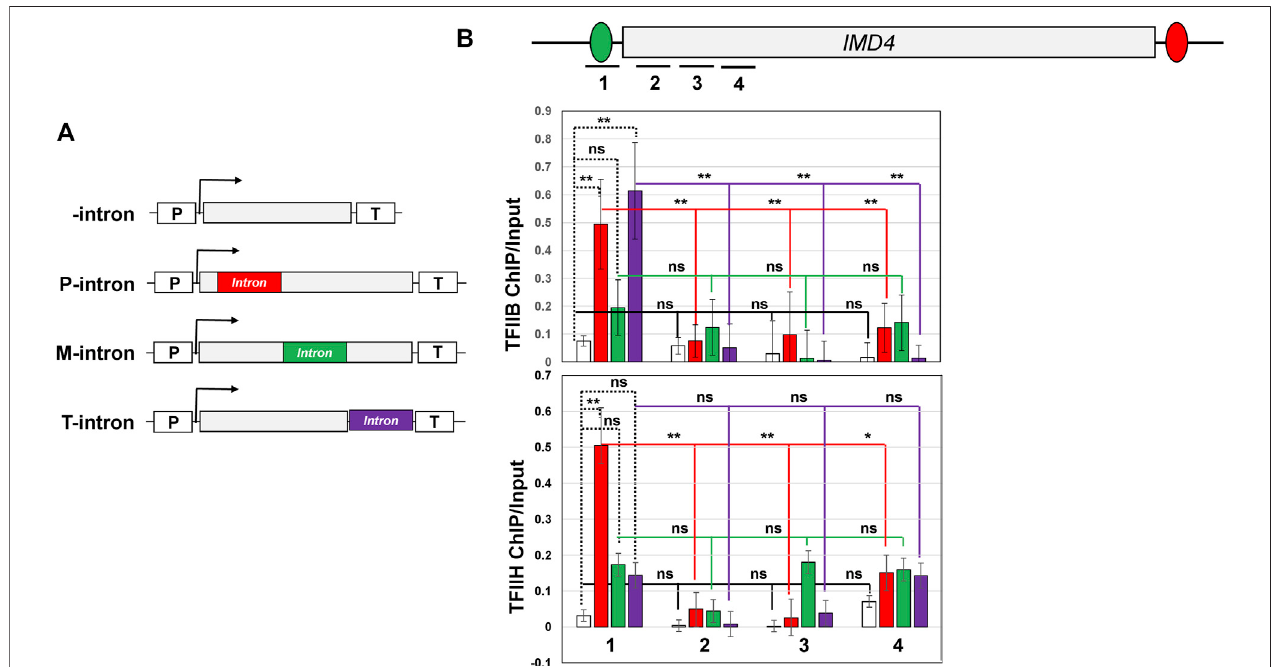
FIGURE5| PositionofintronaffectsTFIIBandTFIIHpromoteroccupancyfor IMD4 gene. (A) Schematicdepictionof IMD4 withoutintronand withthe ACT1 intron inserted near the promoter (P-intron), in the middle (M-intron) and near the terminator region (T-intron) of the gene. “ p ” and “ T ” stand for the promoter and terminator respectively. (B) Schematicdepictionof IMD4 genewithintronindicatingthepositionofprimerpairsusedinChIPanalysis. (C) ChIPanalysisshowingcrosslinkingofHA- taggedTFIIBtothepromoteranddownstreamregionsof IMD4 withpromoter-proximalintron(redbar),middleintron(greenbar),terminator-proximalintron(purple bar)andwithoutintron(whitebar). (D) ChIPanalysisshowingcrosslinkingofTAP-taggedCcl1subunitofTFIIHtothepromoteranddownstreamcodingregionsof IMD4 with promoter-proximal intron (red bar), middle intron (green bar), terminator-proximal intron (purple bar) and without intron (white bar). The Input signal, representing DNA prior to immunoprecipitation, was used as normalization control. ChIP results presented here represent three biological replicates and six technical replicates. The values and error bars for each condition indicate the mean ± standard deviation. Statistical signi fi cance ( p -values) was determined using the two-tailed paired Student ’ s t -test. One asterisk (*) signi fi es a p value equal to or smaller than 0.05 ( p ≤ 0.05). Two asterisks (**) signify a p value equal to or smaller than 0.01 ( p ≤ 0.01). Any non- signi fi cant difference is represented by ns ( p >